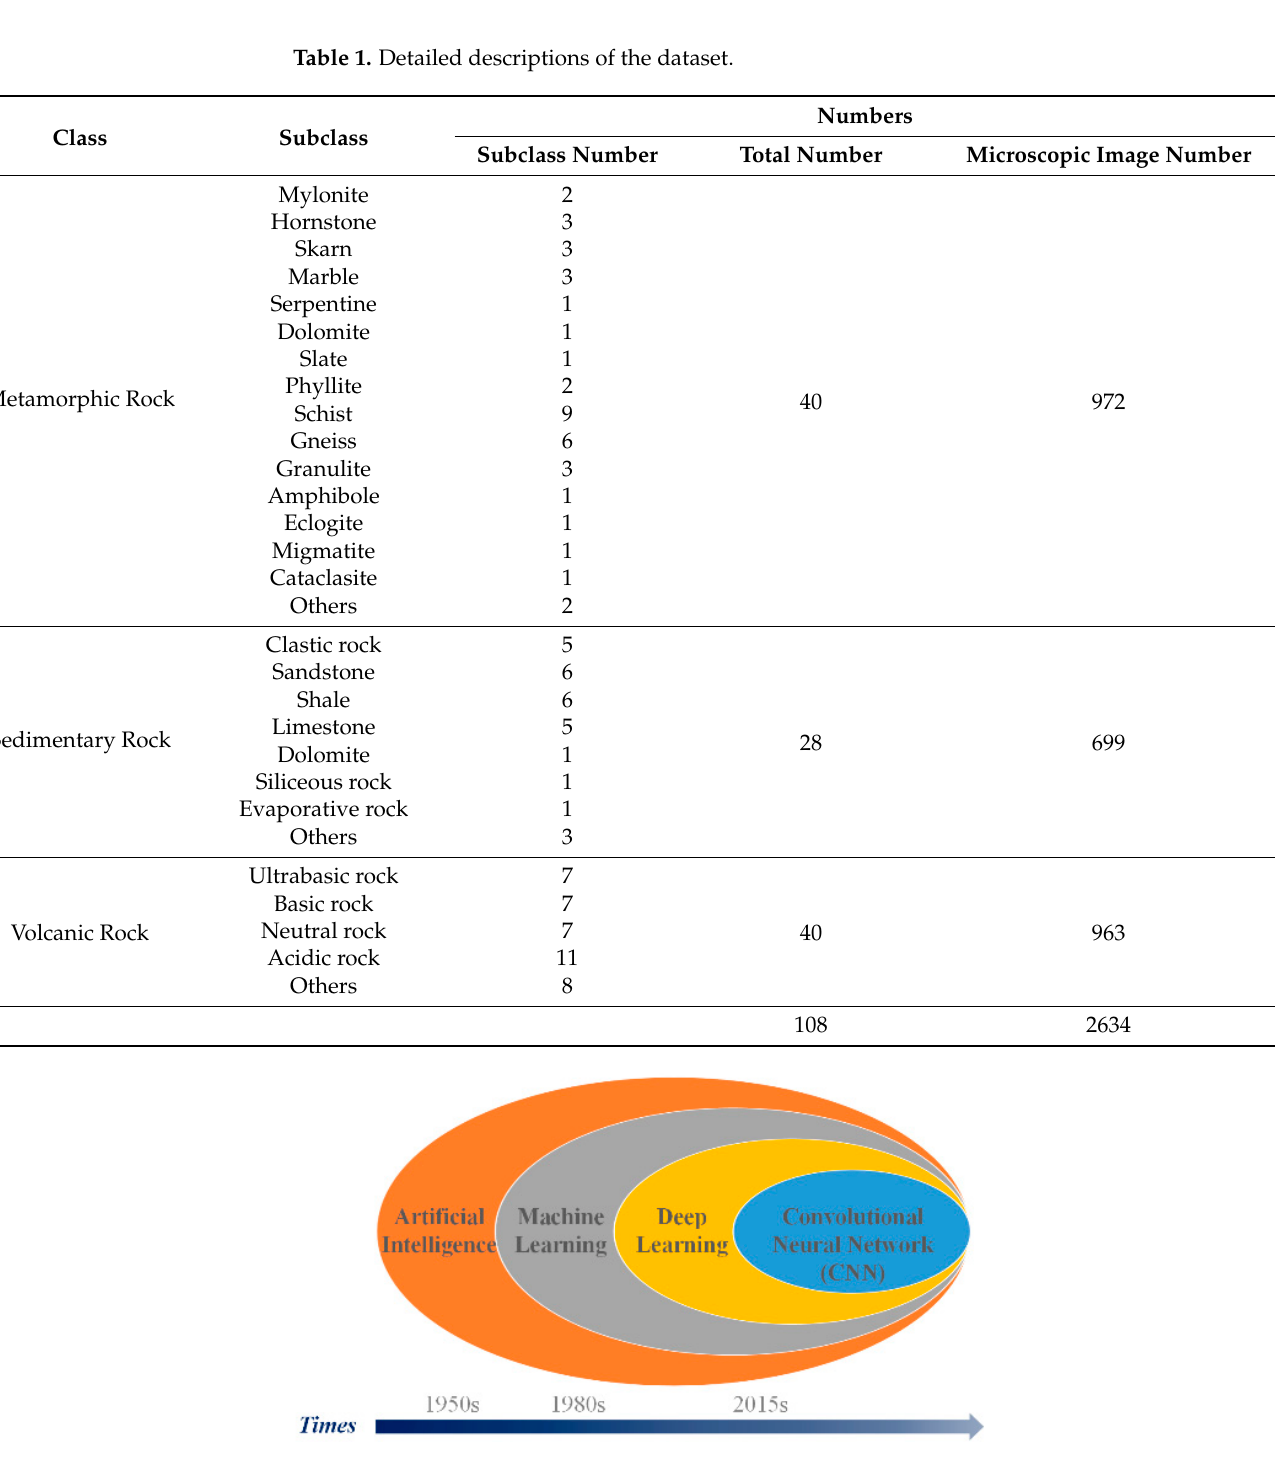
Figure 2. The connection between deep learning and AI [44].